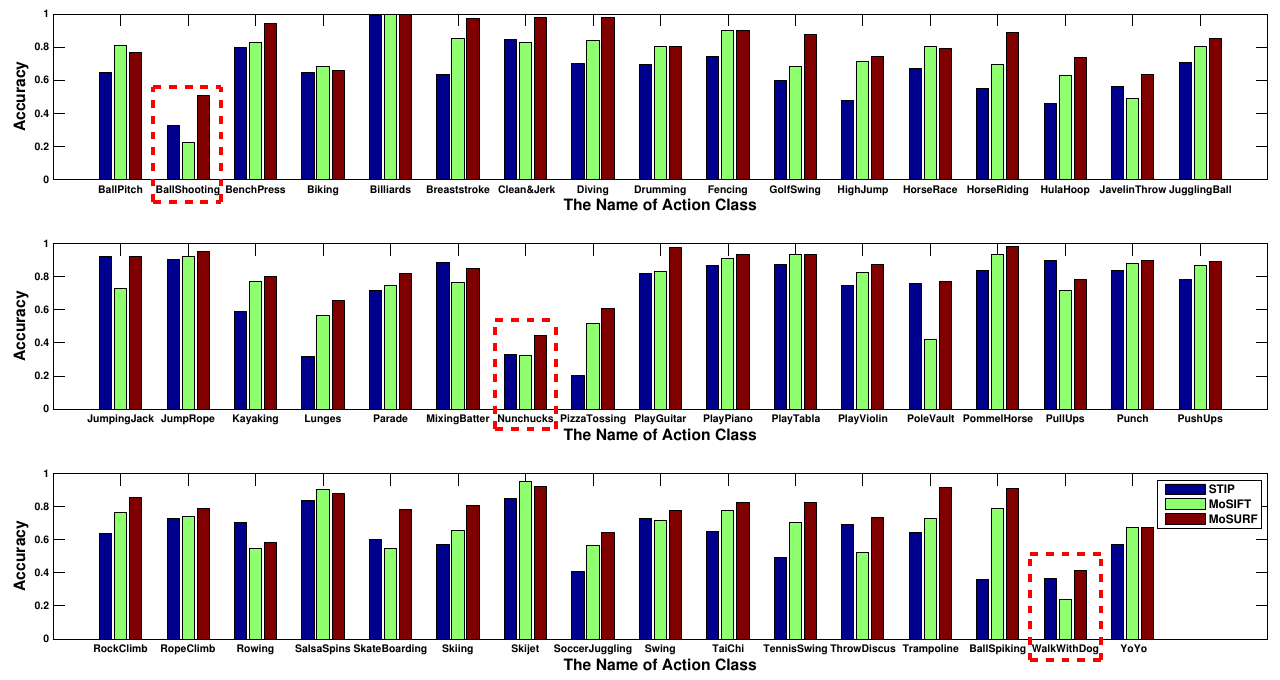
Figure 18. Recognition results of different descriptors. This figure shows the accuracy corresponding to each class of the UCF50 datasets in our experiments.